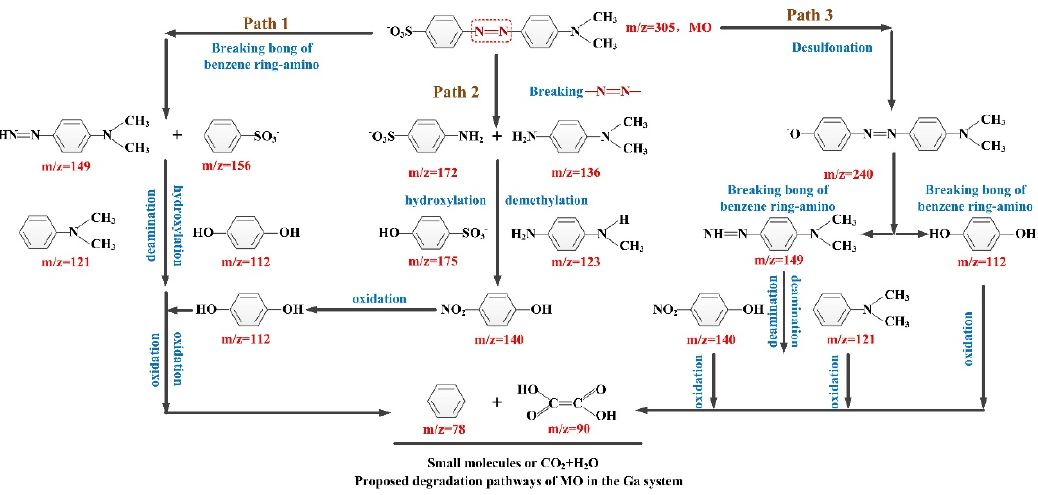
Figure 10. Proposed degradation pathways of MO in the Ga 2 O 3 /ZnO system.